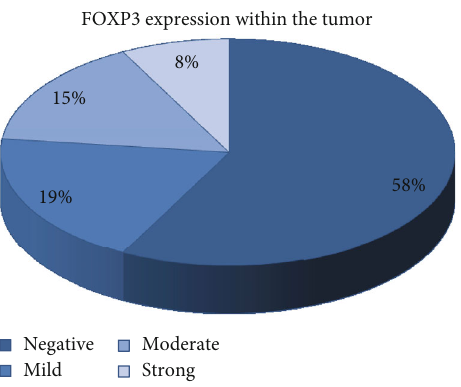
Figure 3: FOXP3 expression in tumor cells.